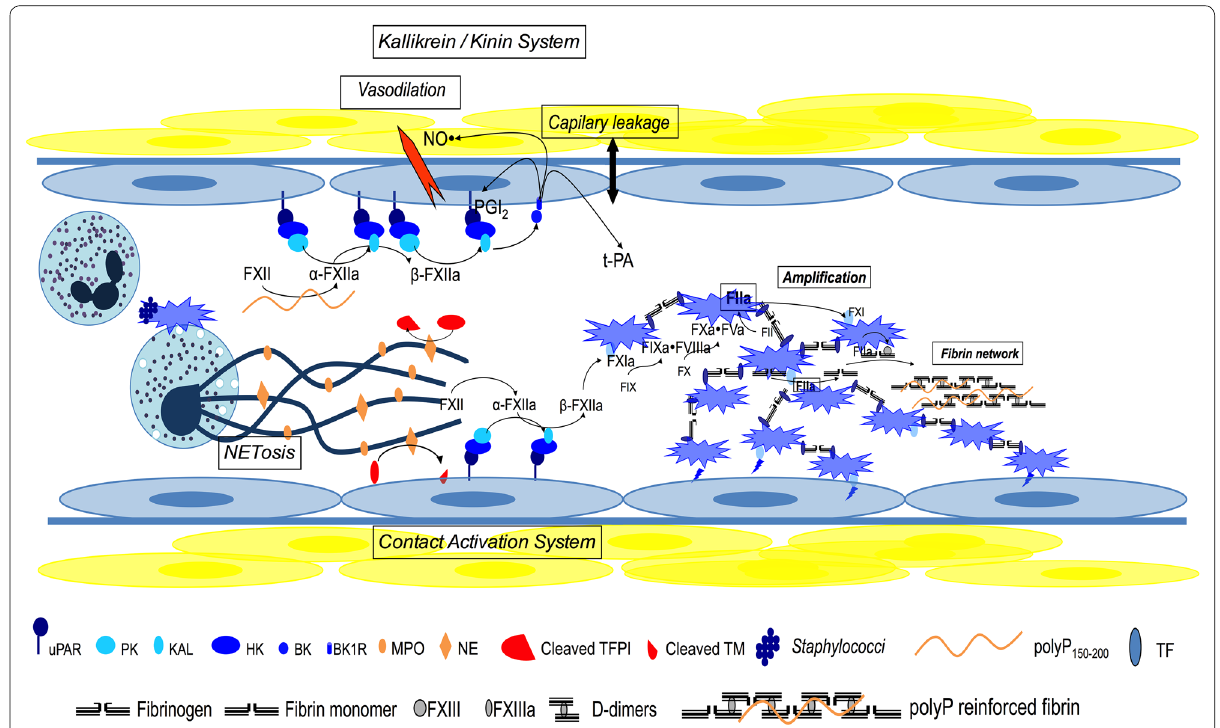
Fig. 1 Immunohaemostasis and infection. During infection, bacteria trigger platelet activation via PF4 and TLRs and can initiate neutrophil extracellular traps (NETs) release by neutrophils after chromatin decondensation and nuclear membrane disruption. Negatively charged DNA, decorated with histones, myeloperoxidase (MPO) and neutrophil elastase (NE), is a potent inducer of FXII auto-activation as well as polyphosphates (polyP 150–200 ) released by bacteria. Both are “contact” activators, i.e. a negatively charged surface able to link and induce a conformational change in FXII that auto-activates FXII in α-FXIIa in the presence of Zn 2 + . Then α-FXIIa converts PK to kallikrein (KAL) that enables a reciprocal hetero-activation of α-FXII, leading to large amount of β-FXIIa and thereafter platelet GP Ib -bound FXI activation. Large amount of FXIIa generated is able to convert platelet-bound FXI into FXIa involved in thrombin generation and fibrin generation. Interestingly, neutrophil elastase (NE) released with NETs is also able to enhance platelet adhesion and activation (inactivation of ADAMTS13) and coagulation with inhibition of tissue factor pathway inhibitor (prolonged tissue factor-induced initiation) and thrombomodulin (impaired activation of protein C). Moreover, polyP 150–200 enhances activation of platelet-bound FXI by FXIIa and can be incorporated in the fibrin network, reinforcing its structure. On the other hand the kallikrein/kinin system (KKS) is also triggered. FXIIa and KAL convert high molecular weight kininogen (HK) in biologically active bradykinin (BK). BK is not involved in thrombin generation, but mainly in inflammatory response via two G-coupled receptors, B1R and B2R. BK results in increased vascular permeability, vasodilation (mediated by both PGI 2 and nitric oxide after iNOS induction), oedema formation and ultimately